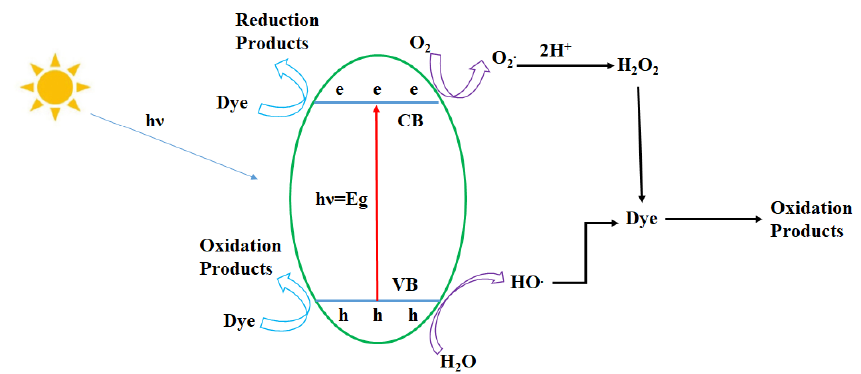
Figure 6. Pictorial representation of indirect dye degradation process.